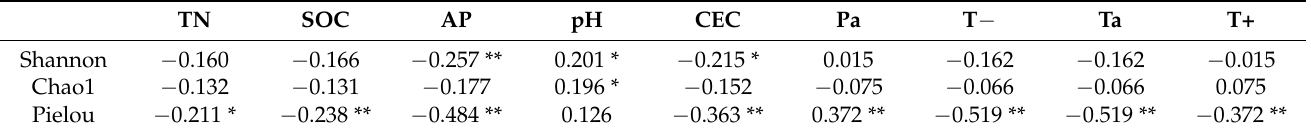
Table 4. Spearman correlation coefficients for fungal diversity and environmental variables.